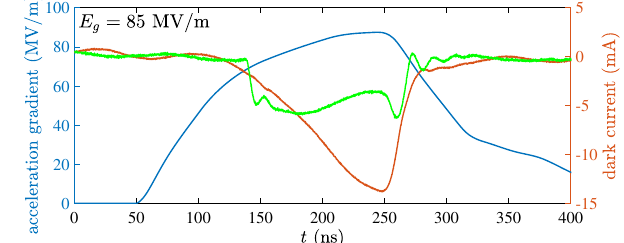
FIG. 14. Sample traces of the gradient (blue), side dark current (green) and downstream dark current (red) measurement results at the finishing stage of the S structure high power test, for a gradient of 85 MV = m